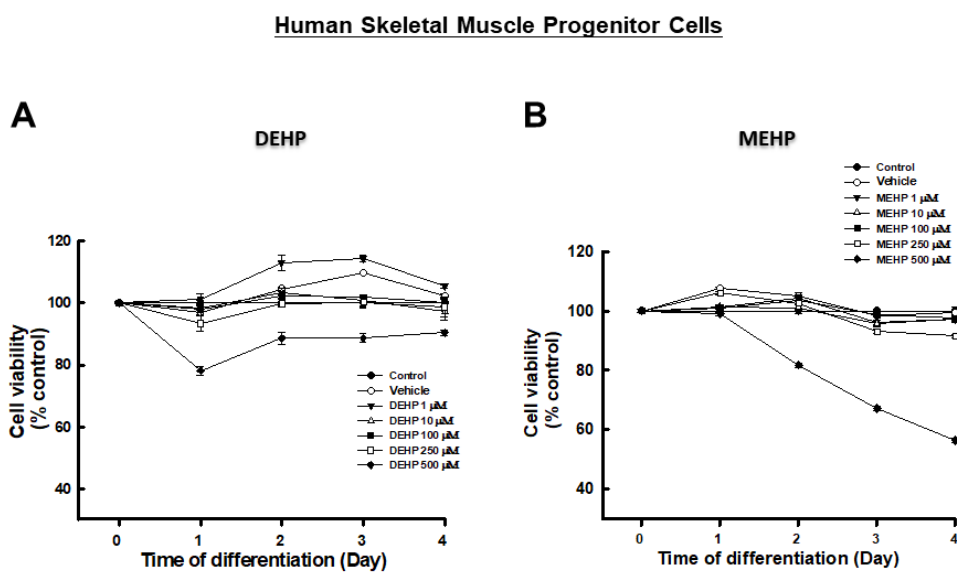
Figure 2. The changes in cell viability in primary HSMPCs treated with both DEHP and MEHP. Under differentiation medium, HSMPCs treated with DEHP ( A ) or MEHP ( B ) (1–500 μ M) for 24–96 h were observed. MTT assay was performed to analyze cell viability ( A , B ). Data are presented as means ± SEM (three independent experiments, triplicate repeats in each).